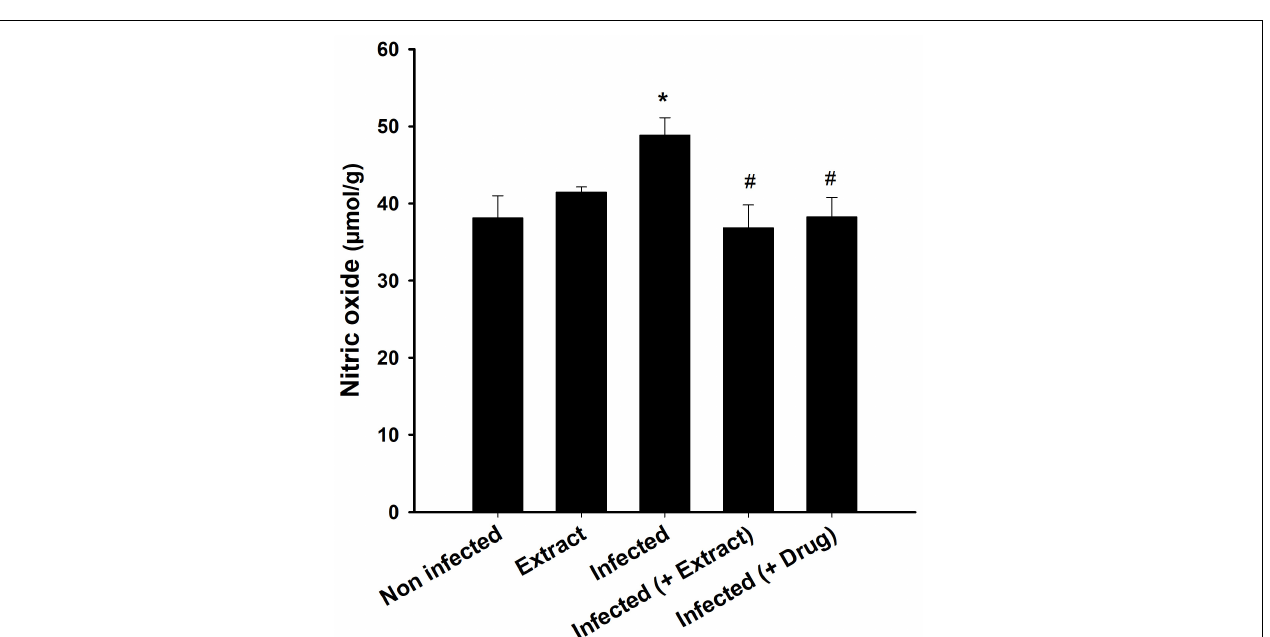
FIGURE 7 | Effect of E. camaldulensis on brain total antioxidant capacity of mice infected with T. evansi . *, significance against control group at p ≤ 0.01. # , significance against infected group at p ≤ 0.01.